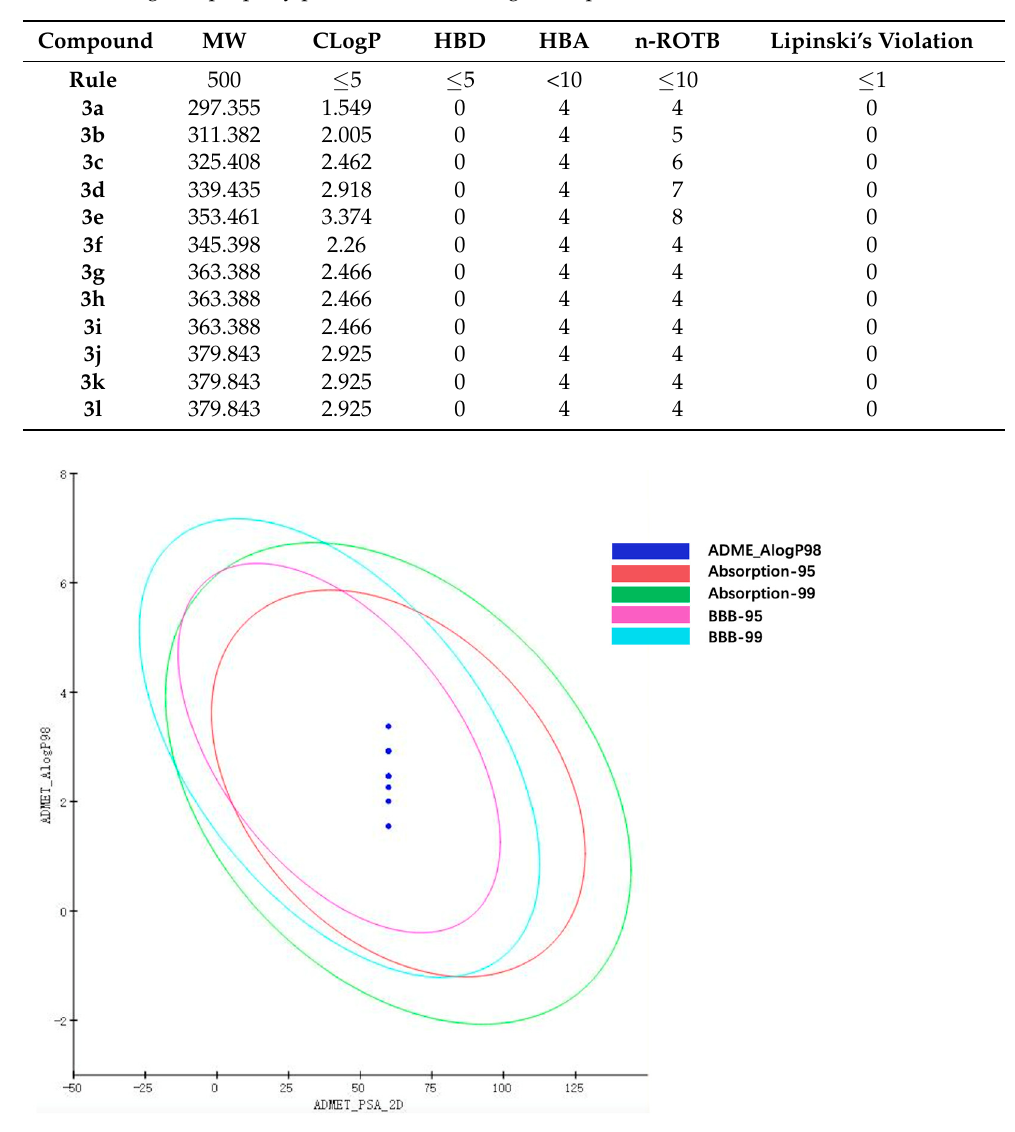
Figure 10. Prediction of ADME/T properties for compounds 3a – l .